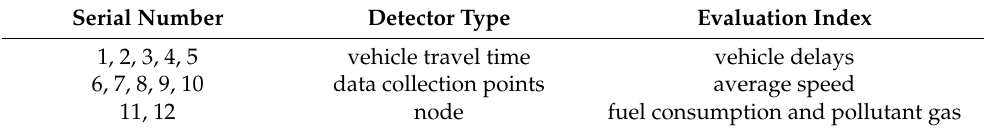
Table 1. Detector